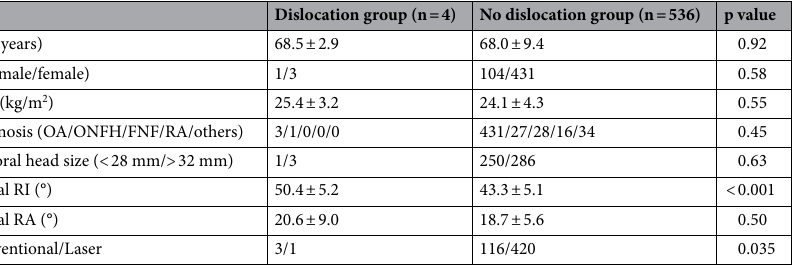
Table 4. Demographic data and surgical information. Values are expressed as mean with standard deviation. BMI body mass index, OA osteoarthritis, ONFH osteonecrosis of the femoral head, FNF femoral neck fracture, RA rheumatoid arthritis, RI radiographic inclination, RA radiographic